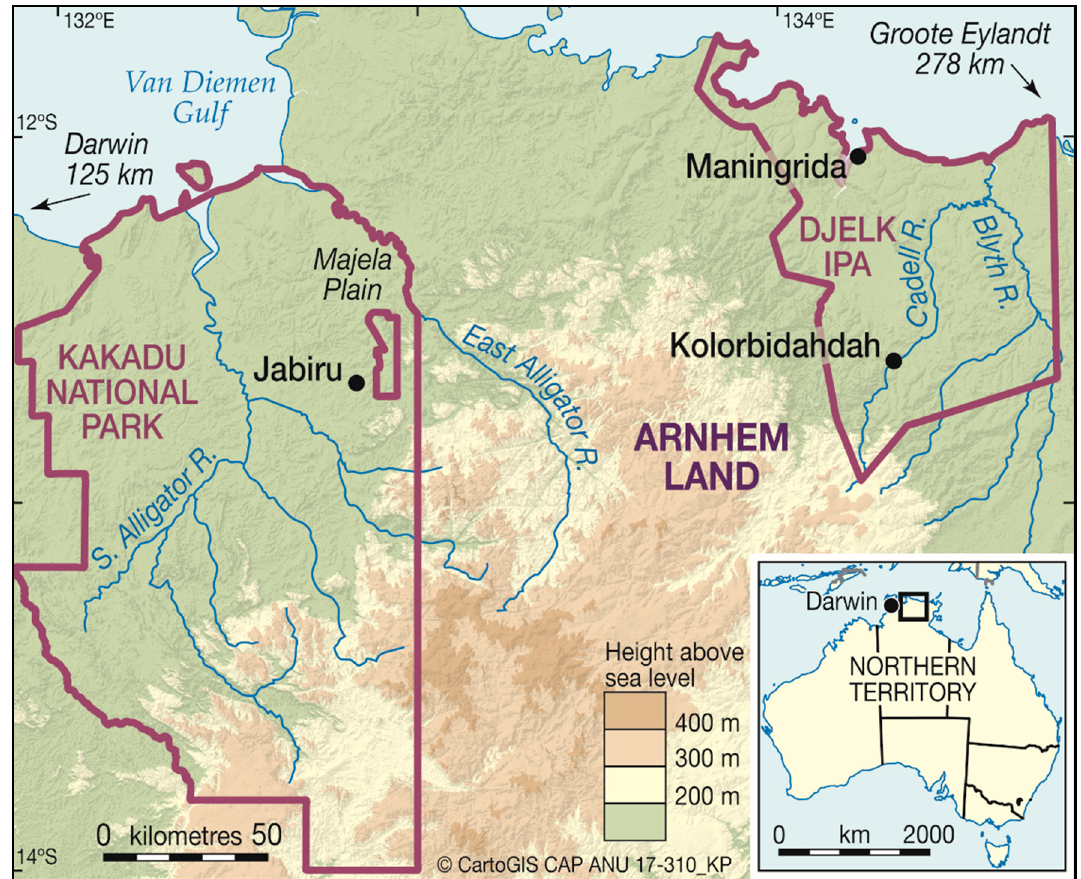
Figure 2. Location and setting of case study sites: Kakadu National Park and Djelk Indigenous Protected Area.